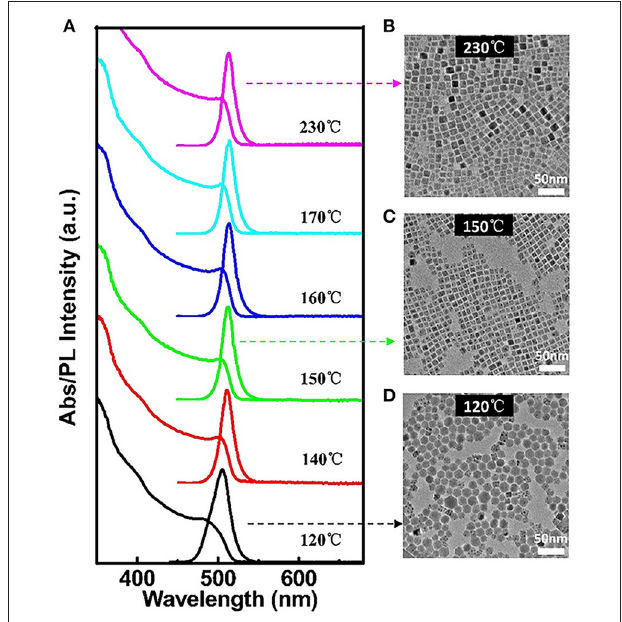
FIGURE 1 | (A) UV-visible absorption and PL spectra of CsPbBr 3 QDs obtained at different injection temperatures after growth for 1min. TEM images of monodisperse CsPbBr 3 QDs with an average diameter of: (B) 11.8nm, (C) 9.6nm, and (D) 15.0nm. The corresponding optical spectra are indicated by dashed